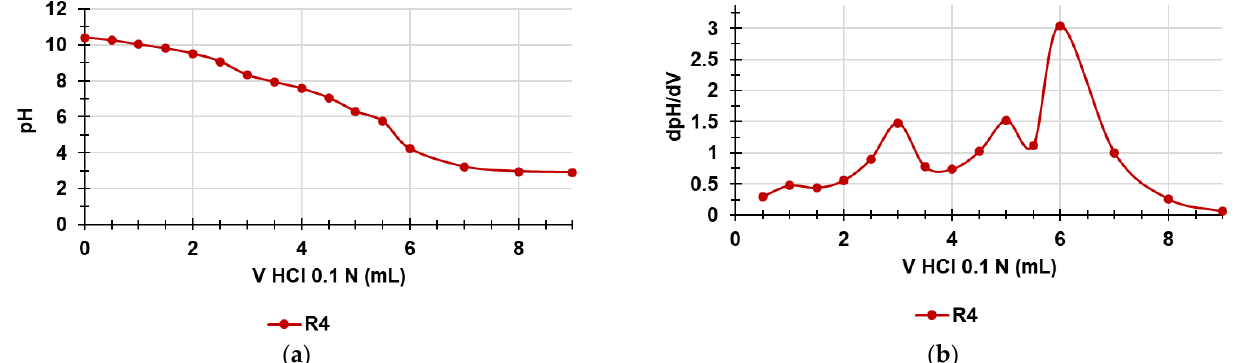
Figure 9. Potentiometric titration of R4 ( a ); first derivative (dpH/dV) of the curve in Figure 10a ( b ) (error bars knowingly omitted).